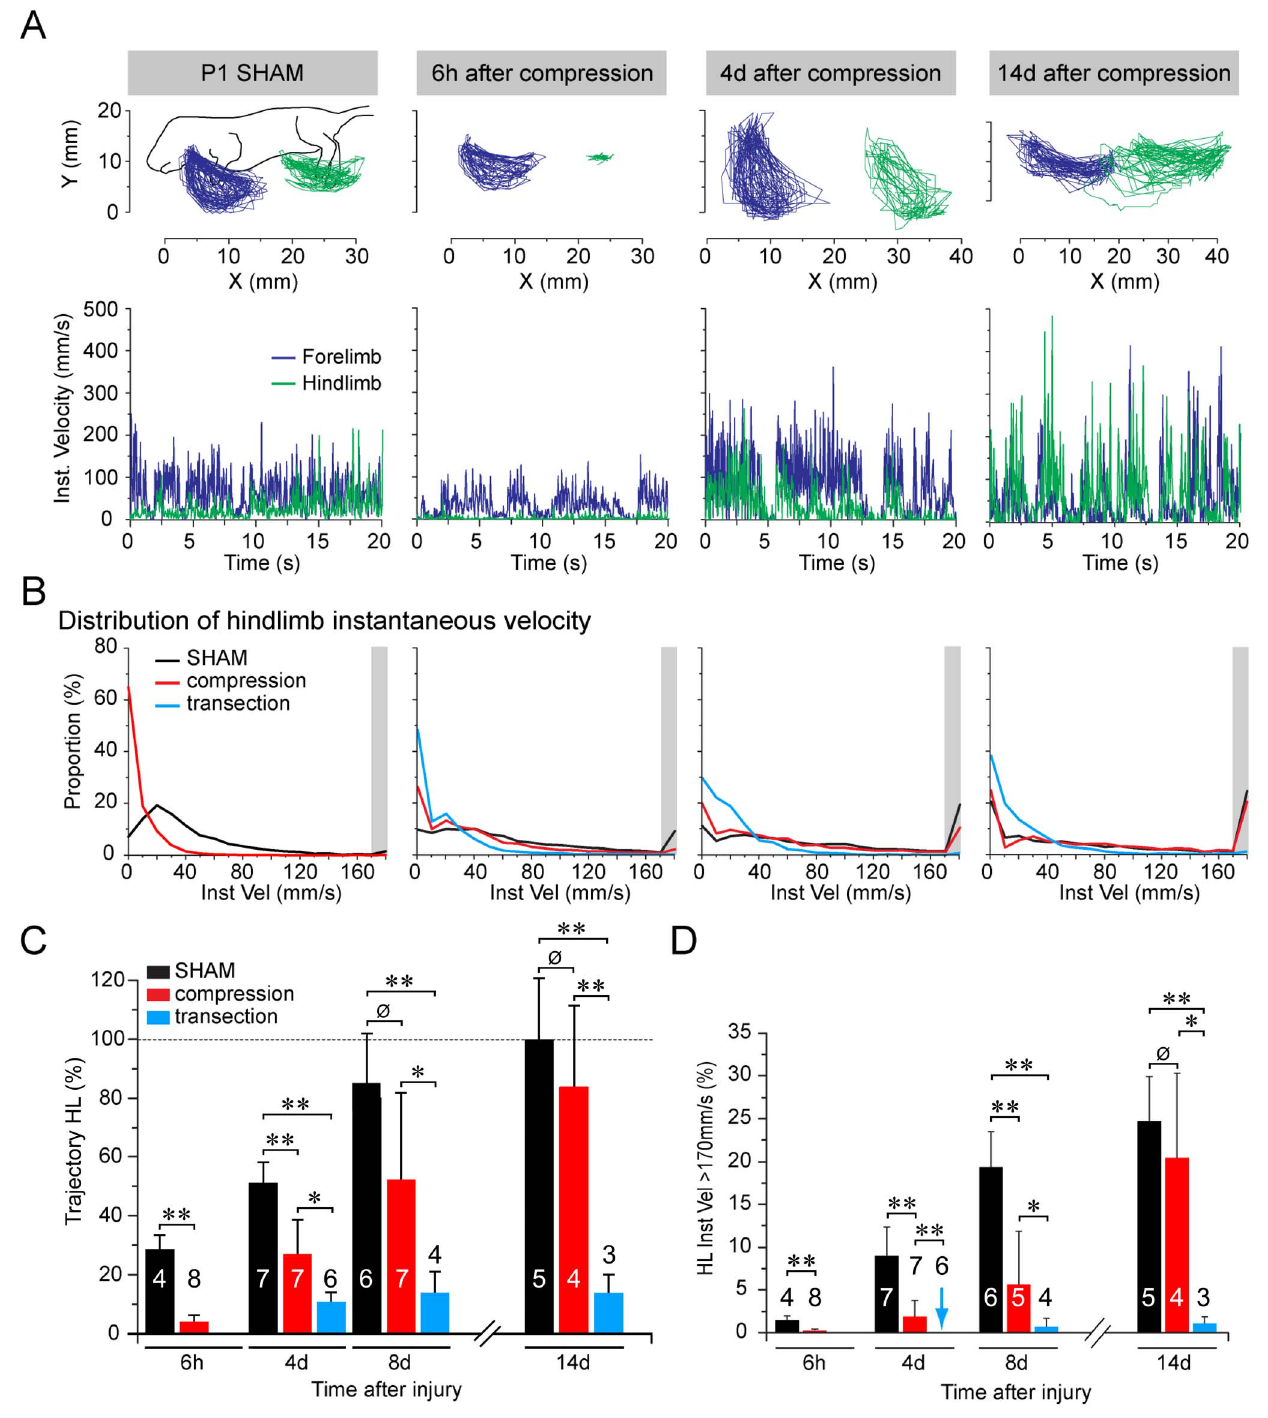
Figure 5. Recovery of hindlimb motility following spinal cord injury. (A) Kinematic assessment of trajectories of forepaws (blue traces) and hindpaws (green traces) during air stepping test of sham control and SCC mice at 3 times post-injury (post-surgery for sham controls). Upper panels show actual trajectories, and lower panels show instantaneous velocities. (B) Distribution of hindlimb instantaneous velocities in sham control (black), SCC (red) and SCT (blue) mice during 20 s video sequences, expressed as the proportion of trajectories with different velocities. Grey zone at far right of each graph indicates the bin containing instantaneous velocities greater then 170 mm/sec. This bin was distinct in that the proportion of velocities over this value increased markedly both in sham control and SCC mice over time. (C) Mean hindlimb trajectory amplitudes in sham control, SCC and SCT mice at different post-injury times normalized to sham controls at 14 days post-surgery. Numbers in or over bars represent numbers of animals tested. Error bars represent standard deviations. Statistical significance of differences of means tested by Mann-Whitney U-test: p # 0.002 (***), p=0.01 (**), p=0.09 (Ø). Note that p value for difference between sham control and SCC mice reaches non-significance by 8 days post-surgery. (D) Proportions of instantaneous velocities . 170 mm/s in sham control, SCC and SCT mice at different times post-surgery/injury. Blue asterisk represents a measurement of value zero, otherwise the lack of a bar indicates that no measurement was made (which was the case for 6 h post-injury for SCT